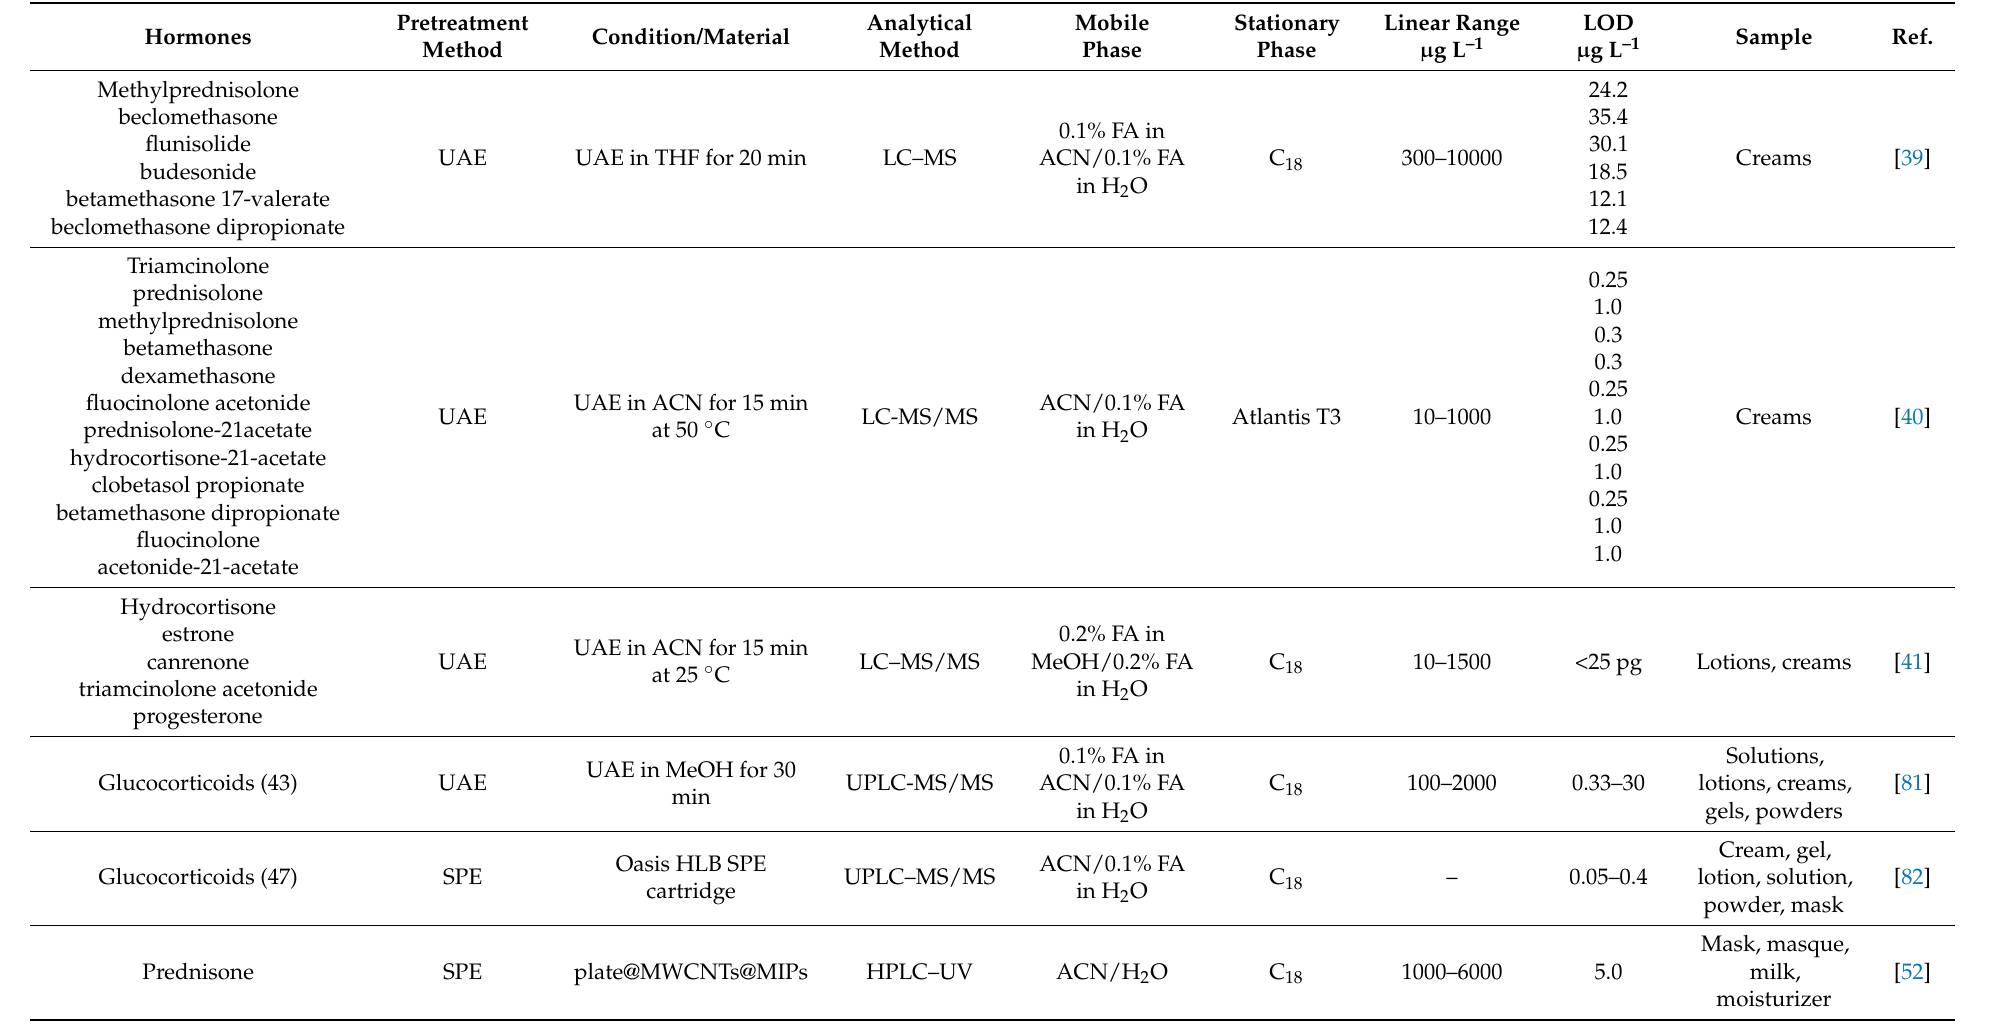
Table 2. Confirmation technologies for hormone determination in